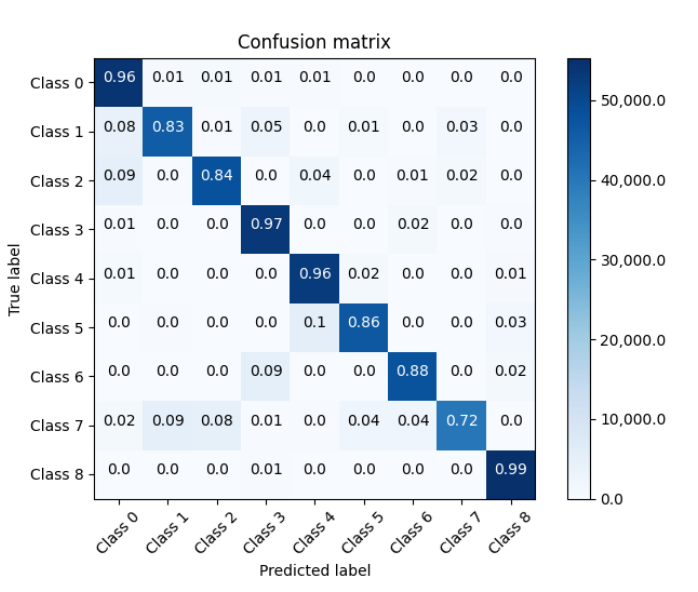
Figure 15. Training and Validation: accuracy and loss function through epochs.